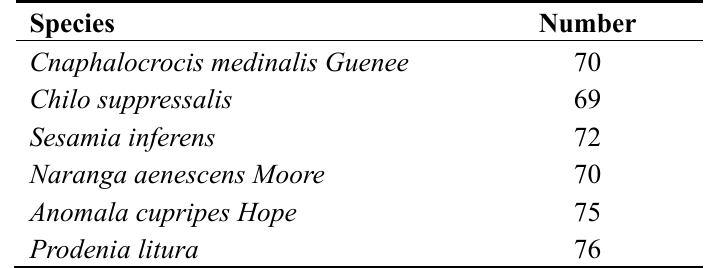
Table 1. Composition of the training sets used to train BP-ANN.